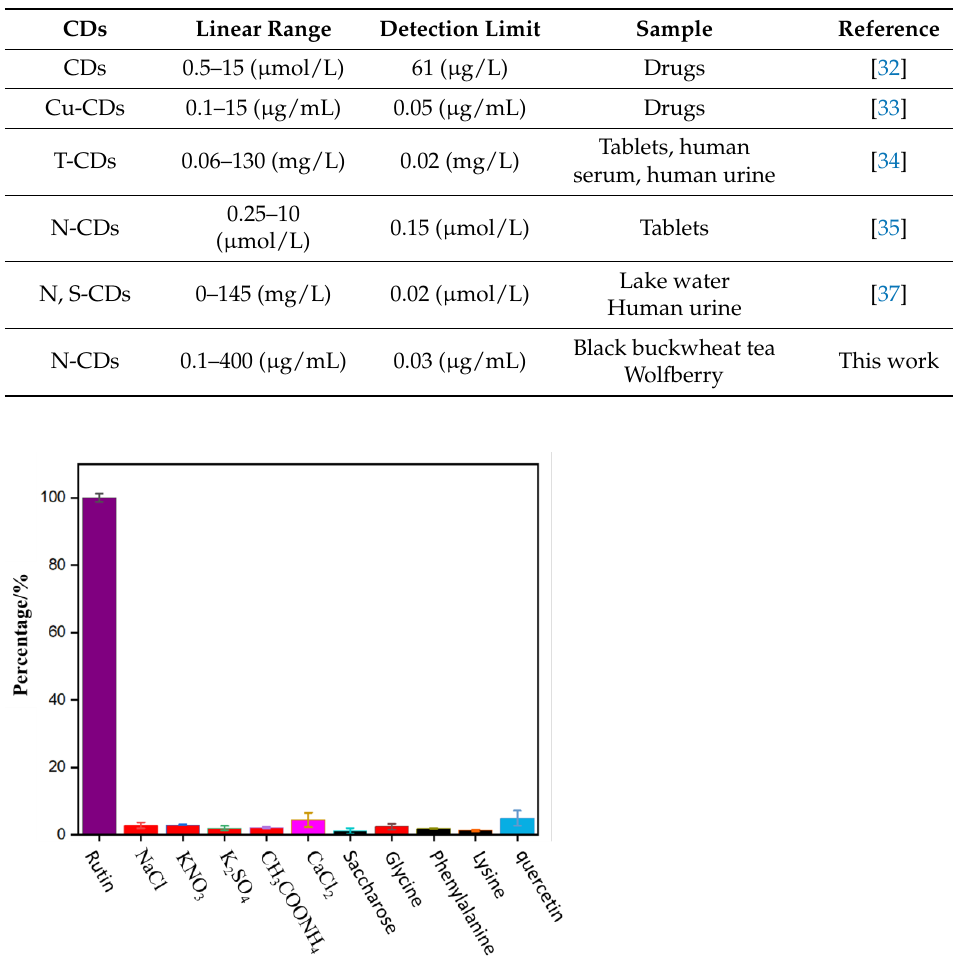
Figure 6. ( A ) Calibration curve of log(F 0 /F) and concentration of rutin (0.1–400 µ g/mL). ( B ) The dependence of log(F 0 /F) on the concentrations of rutin within the range of 0–20 µ g/mL ( n = 6). Table 2. Comparison of rutin detection performance of different CDs as fluorescent probes.